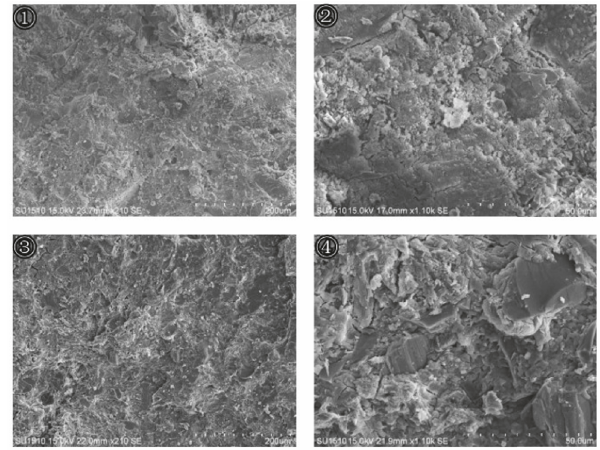
Figure6:SEMphotoofunsinteredsamples(HLWpH=3, AB Fe 2 O 3 free, CD 9% Fe 2 O 3